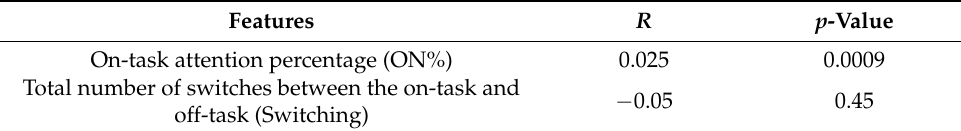
Table 8. Pearson’s Correlation Coefficient ( r ) and p -value between Test 1 and the Attention Features. Features R p -Value On-task attention percentage (ON%) 0.025 0.0009 Total number of switches between the on-task and − 0.05 0.45 off-task (Switching)